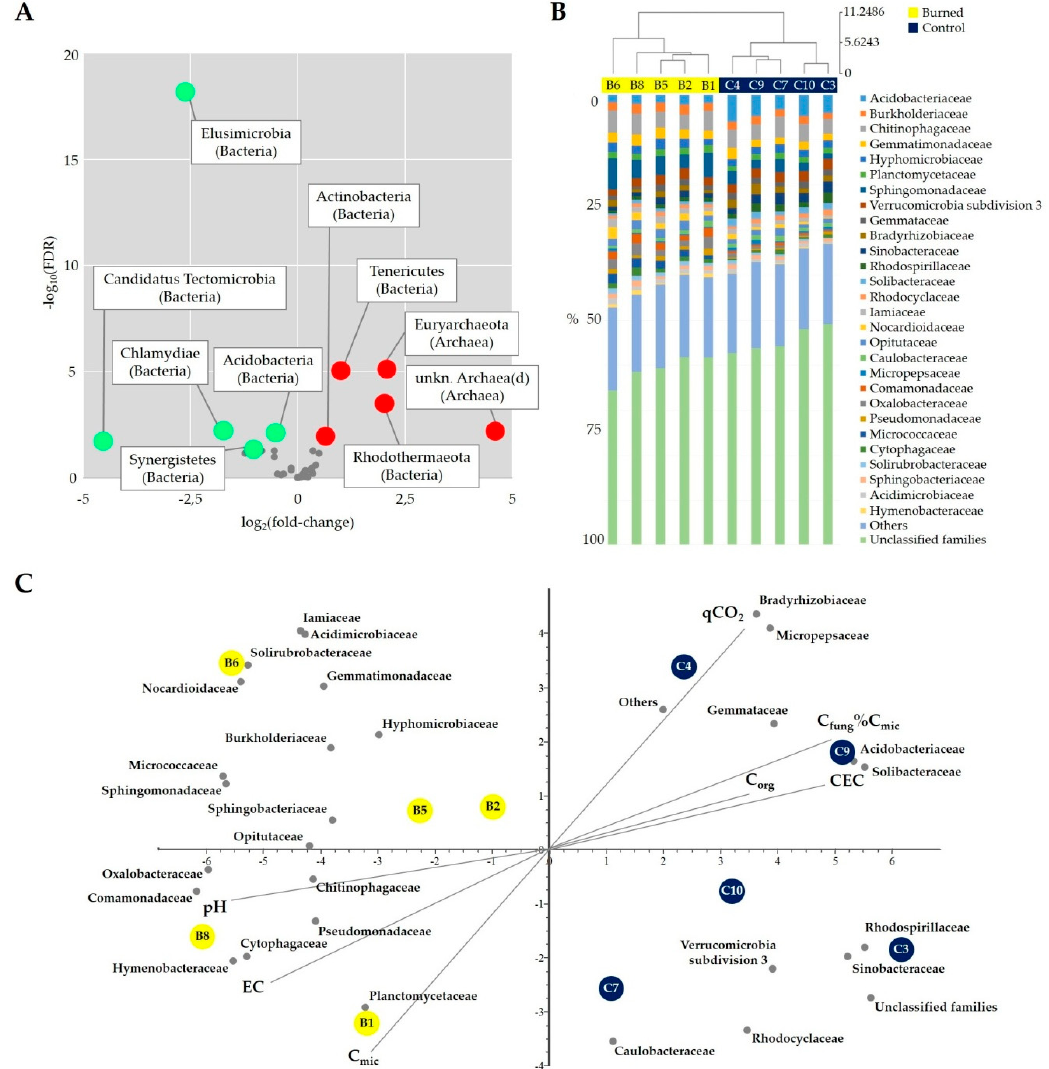
Figure 8. ( A ) Volcano plot representing the relationship between the fold-change (on the X-axis) and the significance of the differential abundance test (Y-axis) for each phylum operational taxonomic units (OTU) (grey circles represent the OTUs that are not significantly differentially represented, while red and green circles are the OTUs that are significantly over- and under-represented in burned soil, respectively). ( B ) Cluster analysis and family level composition of each sample (dendrogram is based on family OTU percentage abundance, using Euclidean distance; only families accounting for at least 1% of sequences are included; all other families are grouped into “Others”). ( C ) Biplot of the Principal Component Analysis of burned (yellow circles) and control (blue circles) plots with the indication of bacterial families (grey circles) and soil variable vectors (grey lines) in the first two principal components space.